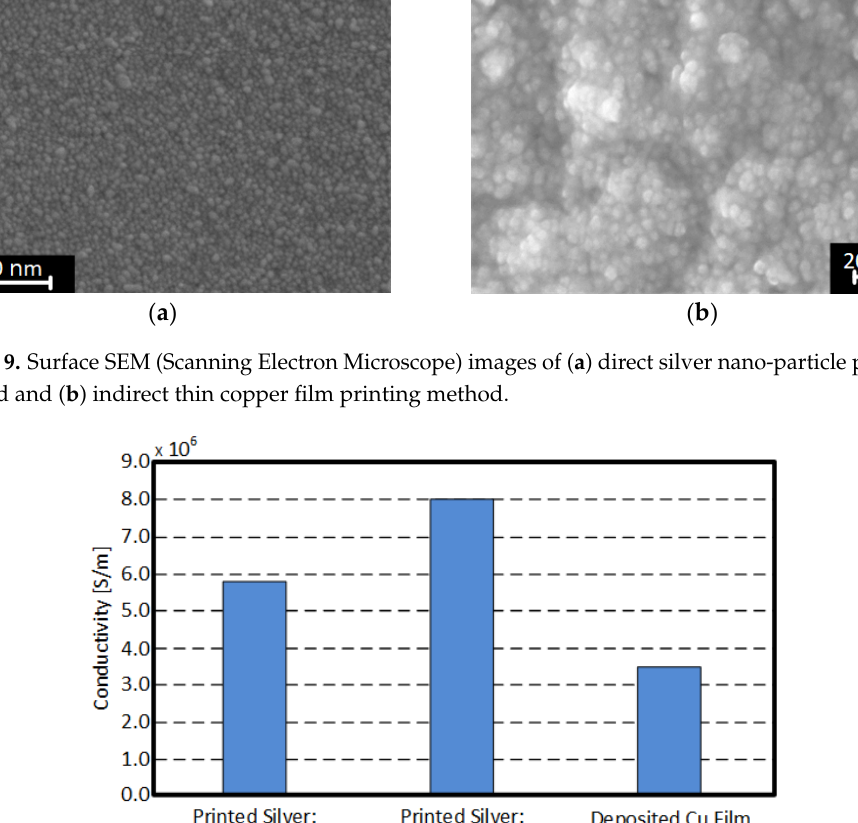
Figure 10. Conductivity values of the printed metal films.